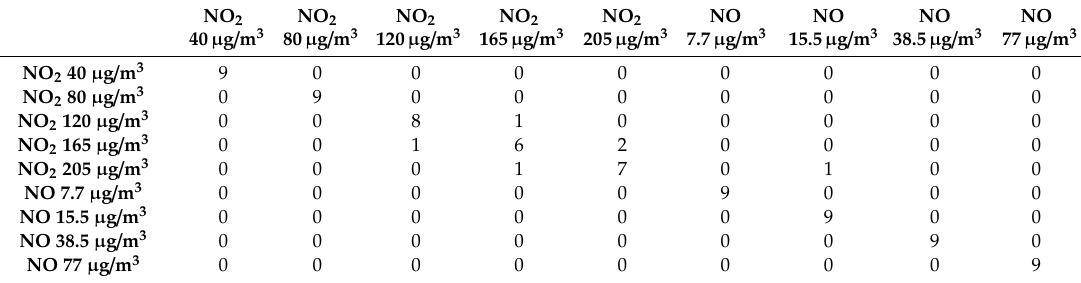
Table 3. Confusion matrix obtained in leave-one-out cross-validation (LOOCV).